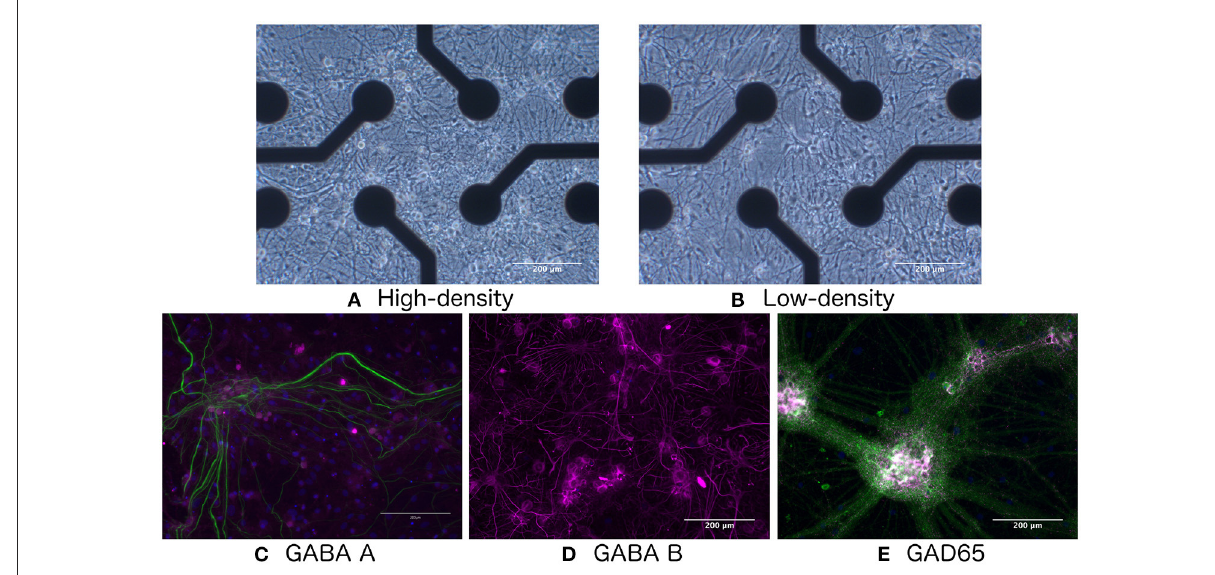
FIGURE1 Bright-field images of (A) high- and (B) low-density networks. Fluorescence images showing the presence of (C) GABA-A, (D) GABA-B, and (E) GAD65. Green indicates neurofilament